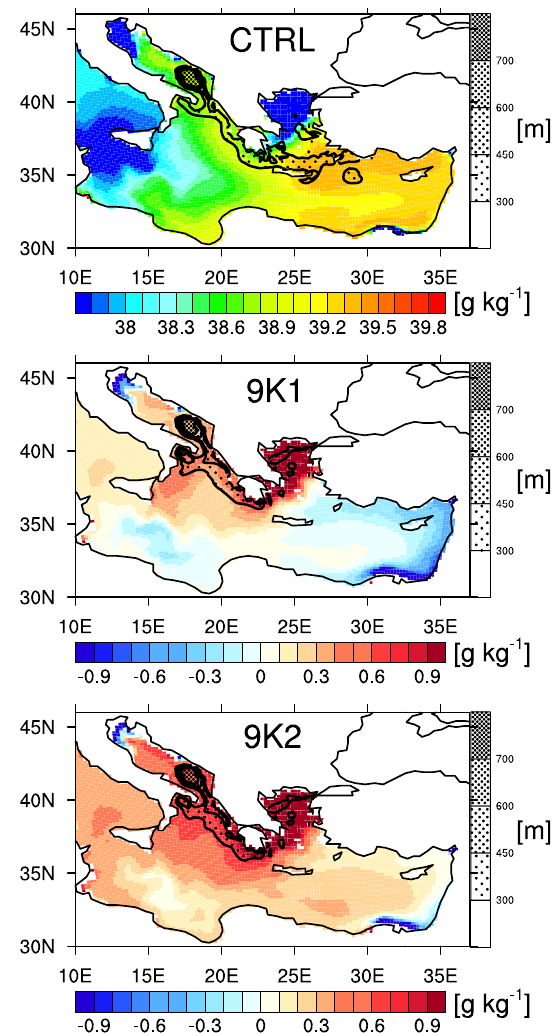
Fig. 9. Annual mean SSS (CTRL, top) and SSS anomalies vs. CTRL (9K1, middle; 9K2, bottom) at 6m depth (colours). March mixed layer depth is overlaid as fill